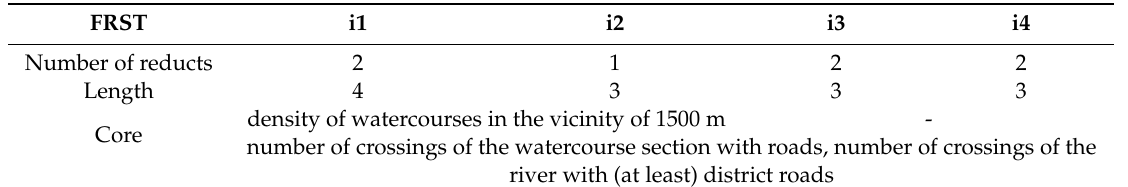
Table 13. Number, size, and cores of designated reducts designated using the FRST method for the selection of sections of watercourses to the scale of 1:50,000.